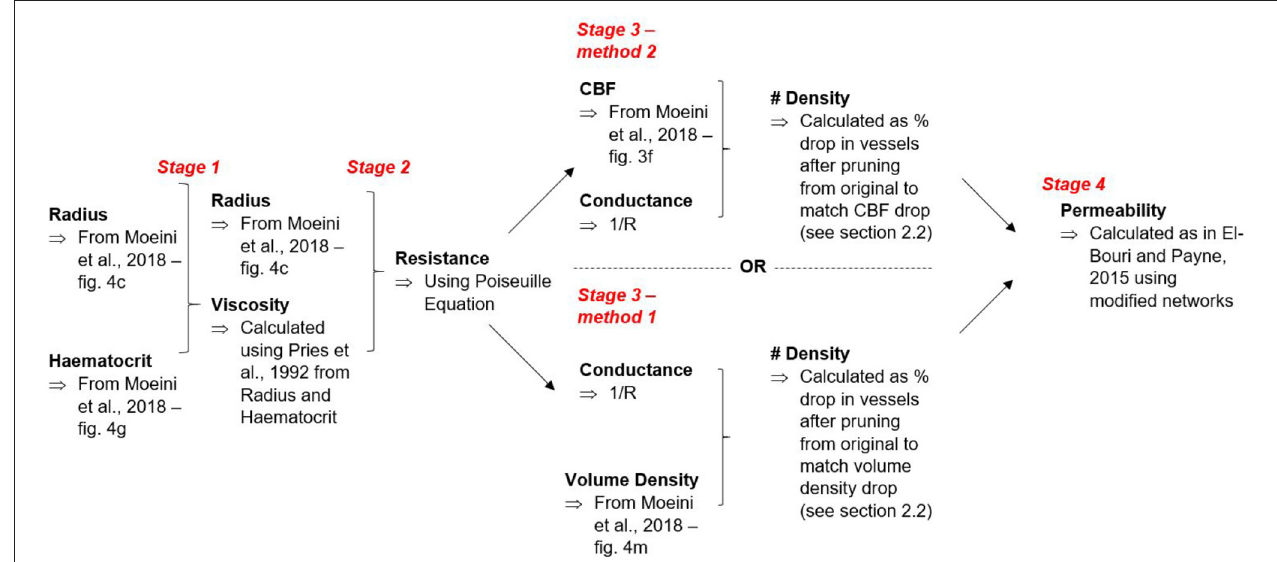
FIGURE 2 | Flowchart mapping route of